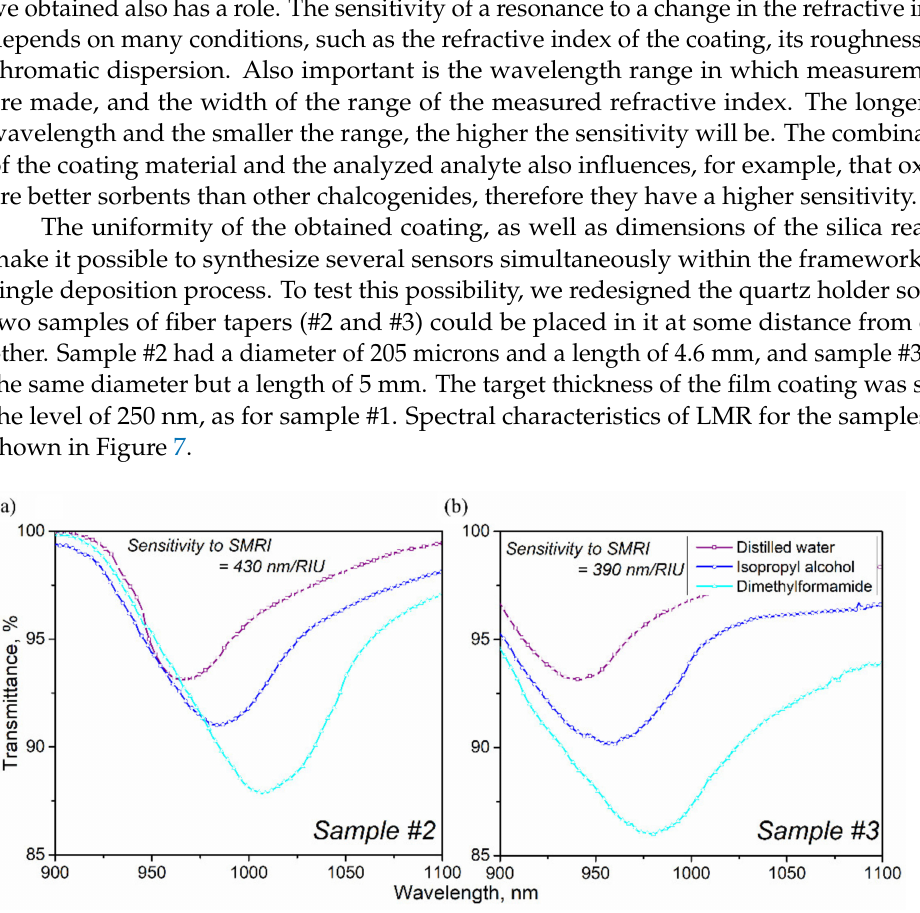
Figure 7. Characteristics of the resonances of the samples: ( a ) #2, ( b )